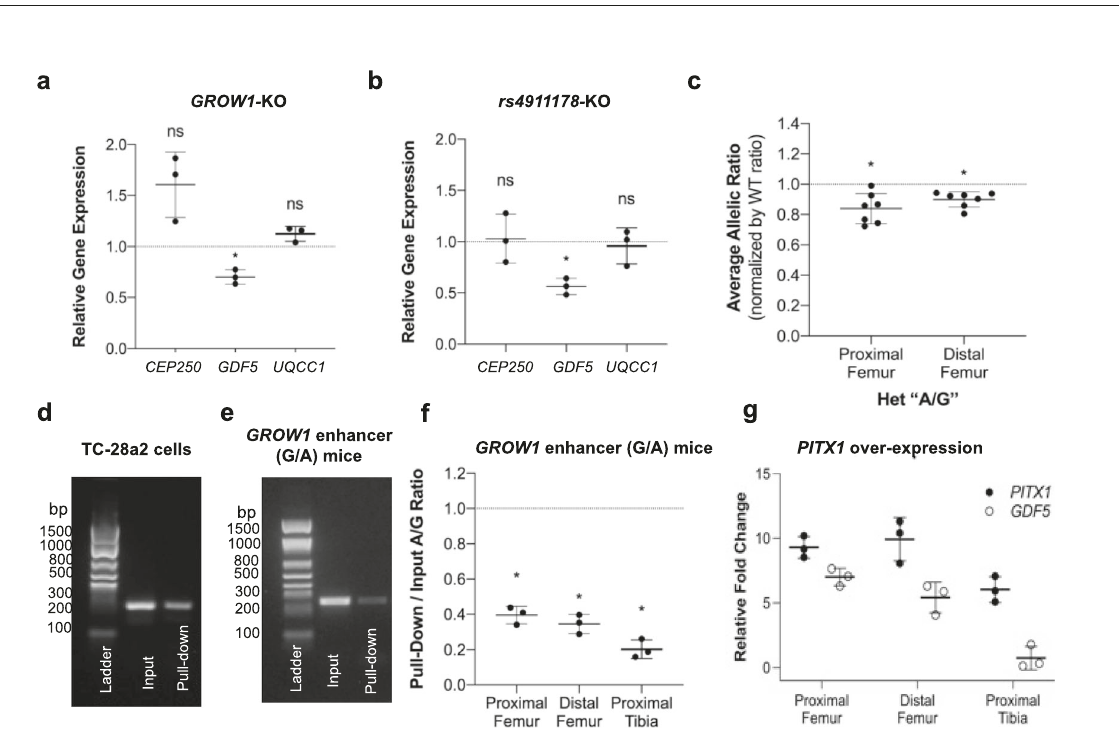
Fig. 3 Molecular characterization of the GDF5 GROW1 enhancer and rs4911178 variant in human chondrocytes and the mouse model. a Expression of CEP250 (non-signi fi cant (0.082)), GDF5 (signi fi cant, p < 0.018), and UQCC 1 ( p = 0.099) in human T/C-28a2 chondrocytes lacking the GROW1 enhancer ( n = 3 biologically independent samples). b Expression of CEP250 ( p = 0.849), GDF5 ( p = 0.011), and UQCC1 ( p = 0.731) in T/C-28a2 cells lacking a 13 bp region containing rs4911178 in GROW1 ( n = 3 biologically independent samples). c ASE assays on E15.5 proximal ( p = 0.019) and distal femur ( p = 0.038) chondrocytes from C57BL/6J/129SvJ GROW1 rs4911178-A/rs4911178- + replacement mice ( n = 7 biologically independent samples). d PITX1 ChIP assay on a 234 bp GROW1 sub-region containing rs4911178 in human T/C-28a2 chondrocytes showing input (left) and pull-down (right) in the gel image. This experiment was repeated three times independently with similar results. e PITX1 ChIP assay on a 255 bp GROW1 sub-region containing rs4911178 in GROW1 rs4911178-A/rs4911178-G mice showing input and pull-down from E15.5 proximal femur. This experiment was repeated three times independently with similar results. f A/G allelic ratio in PITX1 ChIP pull-down compared to input from GROW1 rs4911178-A/rs4911178-G mice (39.6% decrease in ‘ A ’ over G, p = 0.002 in the proximal femur; 34.5% decrease in ‘ A ’ over ‘ G ’ , p = 0.002 in distal femur; 20.2% decrease in ‘ A ’ over ‘ G ’ , p = 0.001 in proximal tibia) ( n = 3 biologically independent samples). g Fold-change for PITX1 and Gdf5 gene expression in PITX1 over-expressed chondrocytes cultured from E15.5 embryonic hind limb buds (proximal femoral, distal femoral, and proximal tibia). Summary data are presented as mean and standard deviations. All p -values are two- amplicons from this PITX1 over-expression experiment, we found there was an enhanced allelic imbalance whereby the overexpression of PITX1 also increased the differential binding of “ G ” versus “ A ” allele as anticipated (4.136-fold increased binding of “ G ” allele to PITX1) in the proximal femur. Overall, these data demonstrate that the “ A ” risk variant at rs4911178 directly decreases PITX1 binding, revealing a molecular mechanism of action of the variant change at the speci fi c variant and most markedly in the proximal femur.